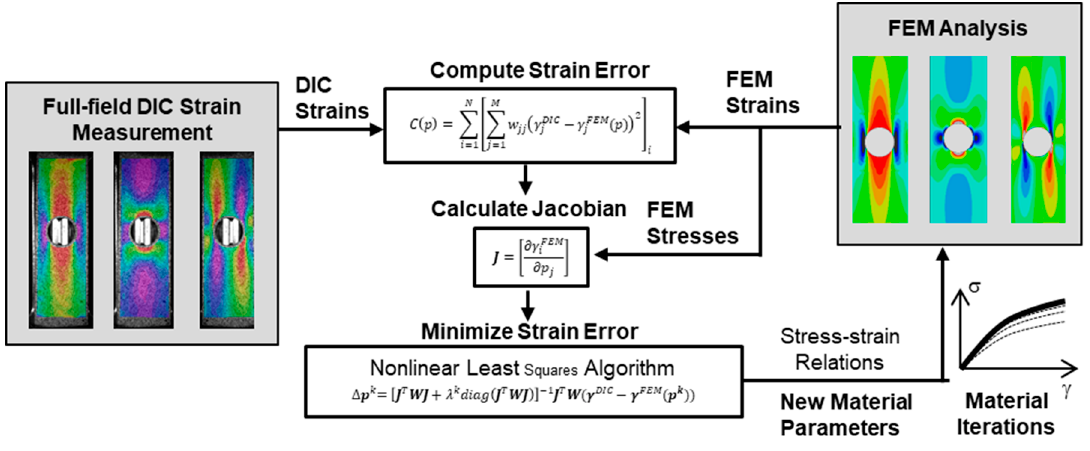
Figure 8. Finite element model updating (FEMU) algorithm for DIC data-driven modeling in unidirectional OHC specimens.